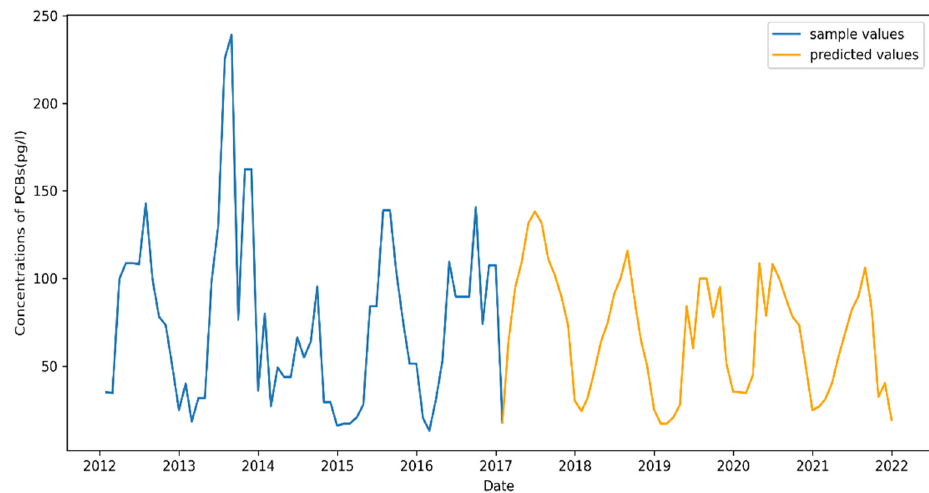
Figure 12. The predicted concentration values of PCBs at Point Petre in the next 5 years.